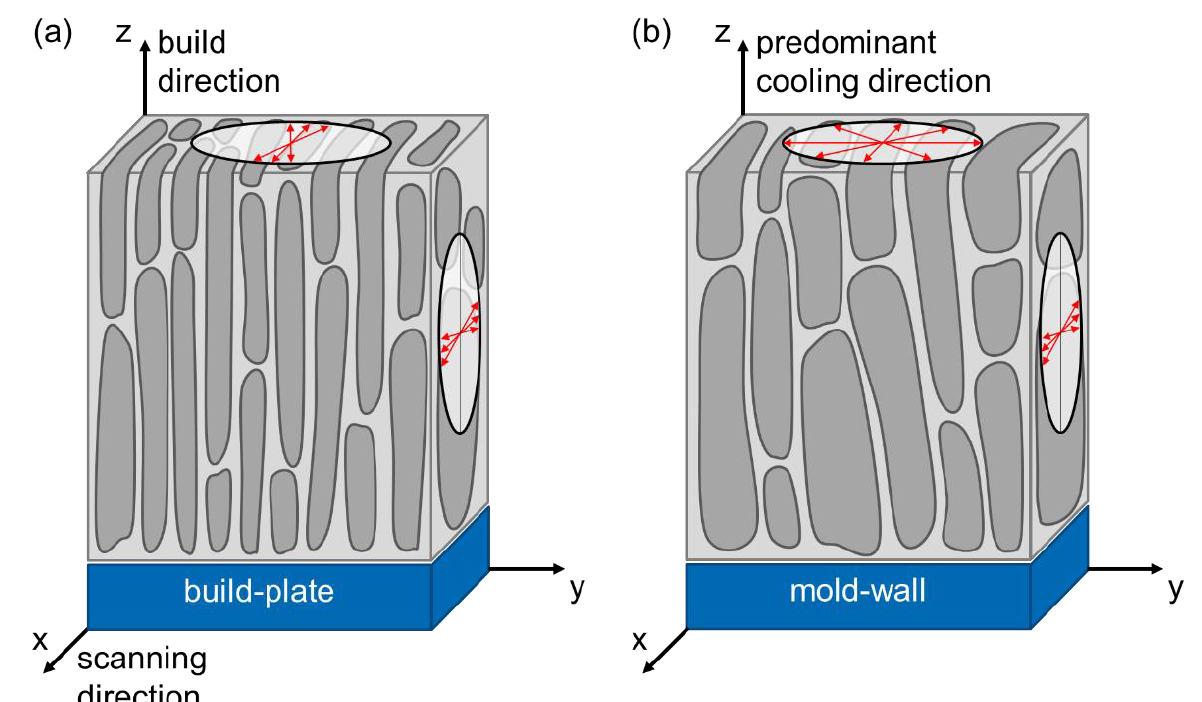
Figure 8. Schematic presentation of the FePrCuB sample orientation and allocation of the axes in the samples ( a ) L-PBF-a and ( b ) BMC-a . In both cases, the z axis is assigned to the direction with the highest temperature gradient during solidification. Based on results from Section 3, typical orientations of c axes of Fe 14 Pr 2 B grains are qualitatively indicated by red arrows.